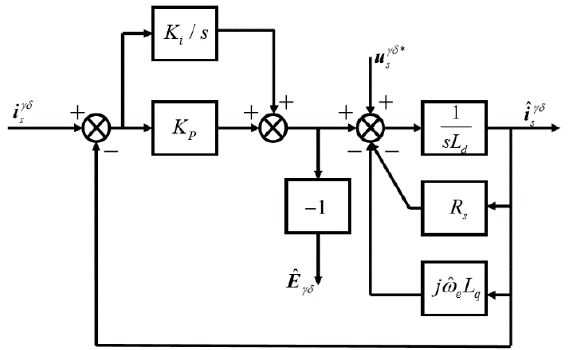
Figure 2. The structure of extended back electromotive force (back-EMF) Luenberger observer .